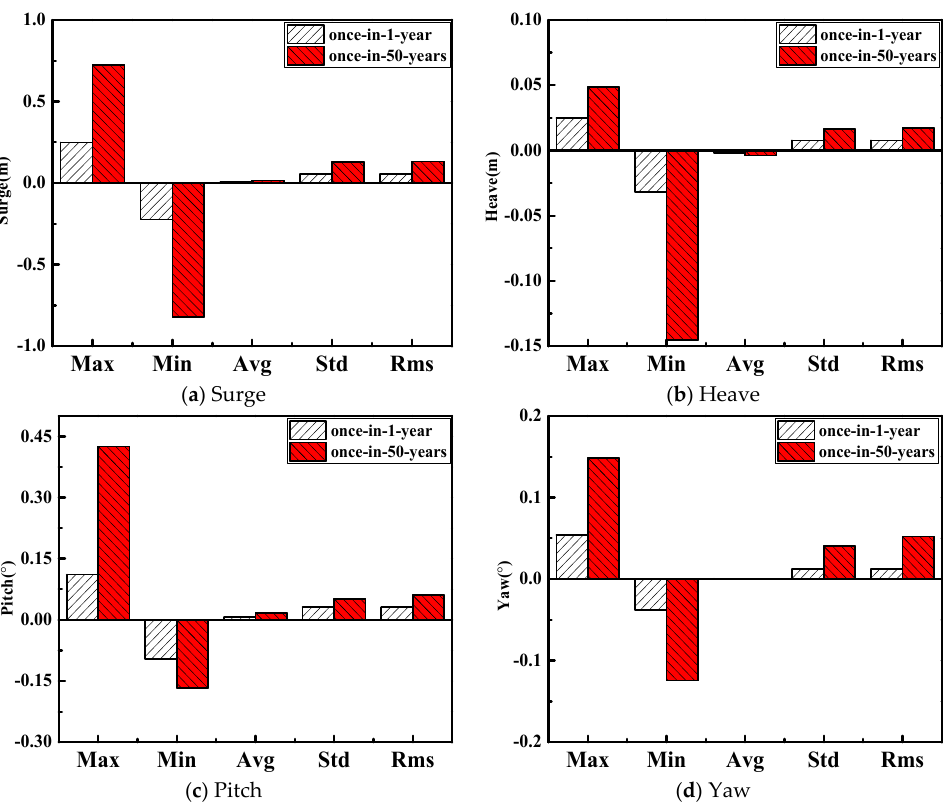
Figure 17. Motion statistics of the platform under extreme sea-states.